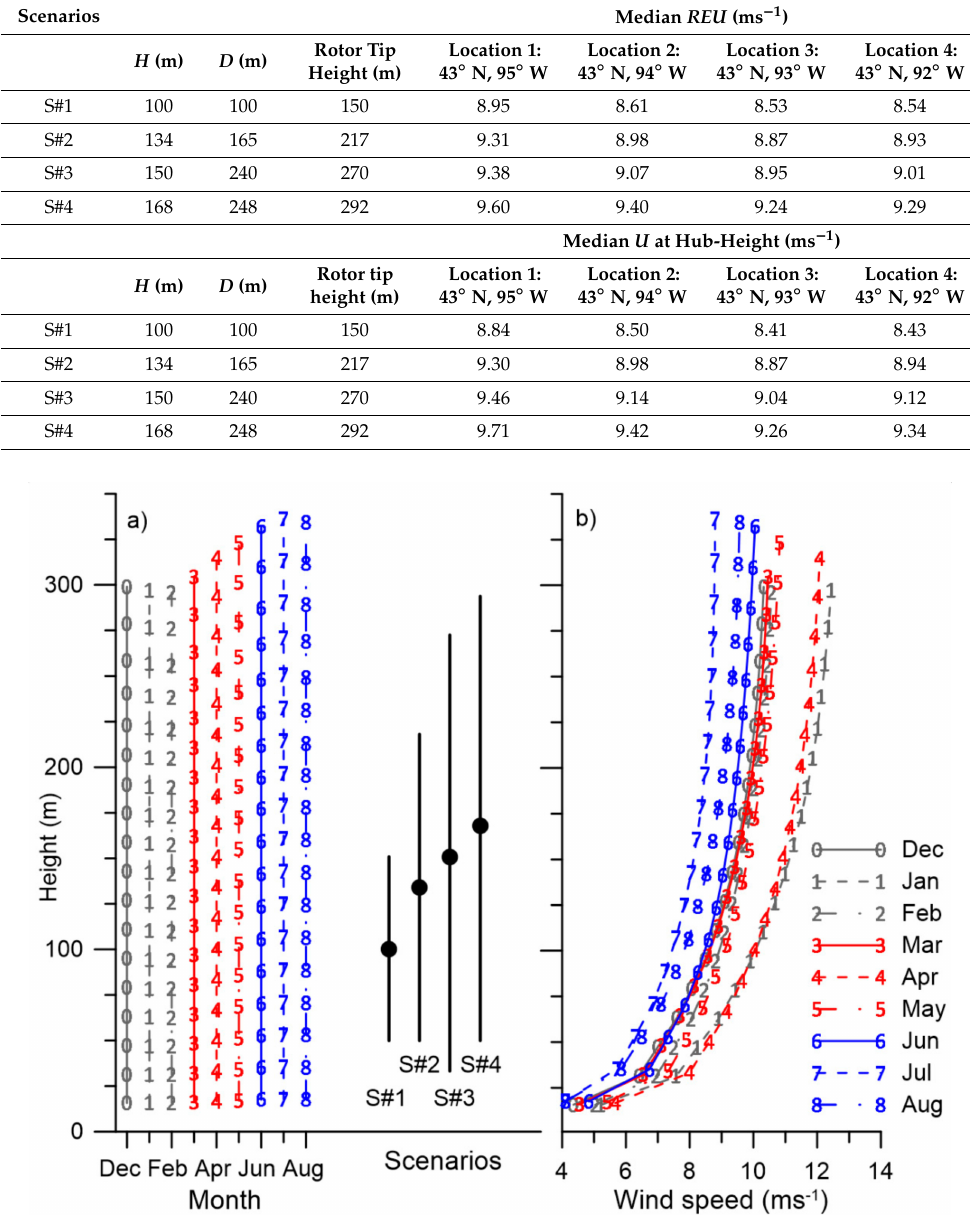
Table 1. Physical dimensions ( H and D ) of the WT used in the four scenarios (S#x) and time-averaged (median) rotor equivalent ( REU ) and hub-height wind speeds ( U ) at the four locations on the transect across northern Iowa (see Figure 2).